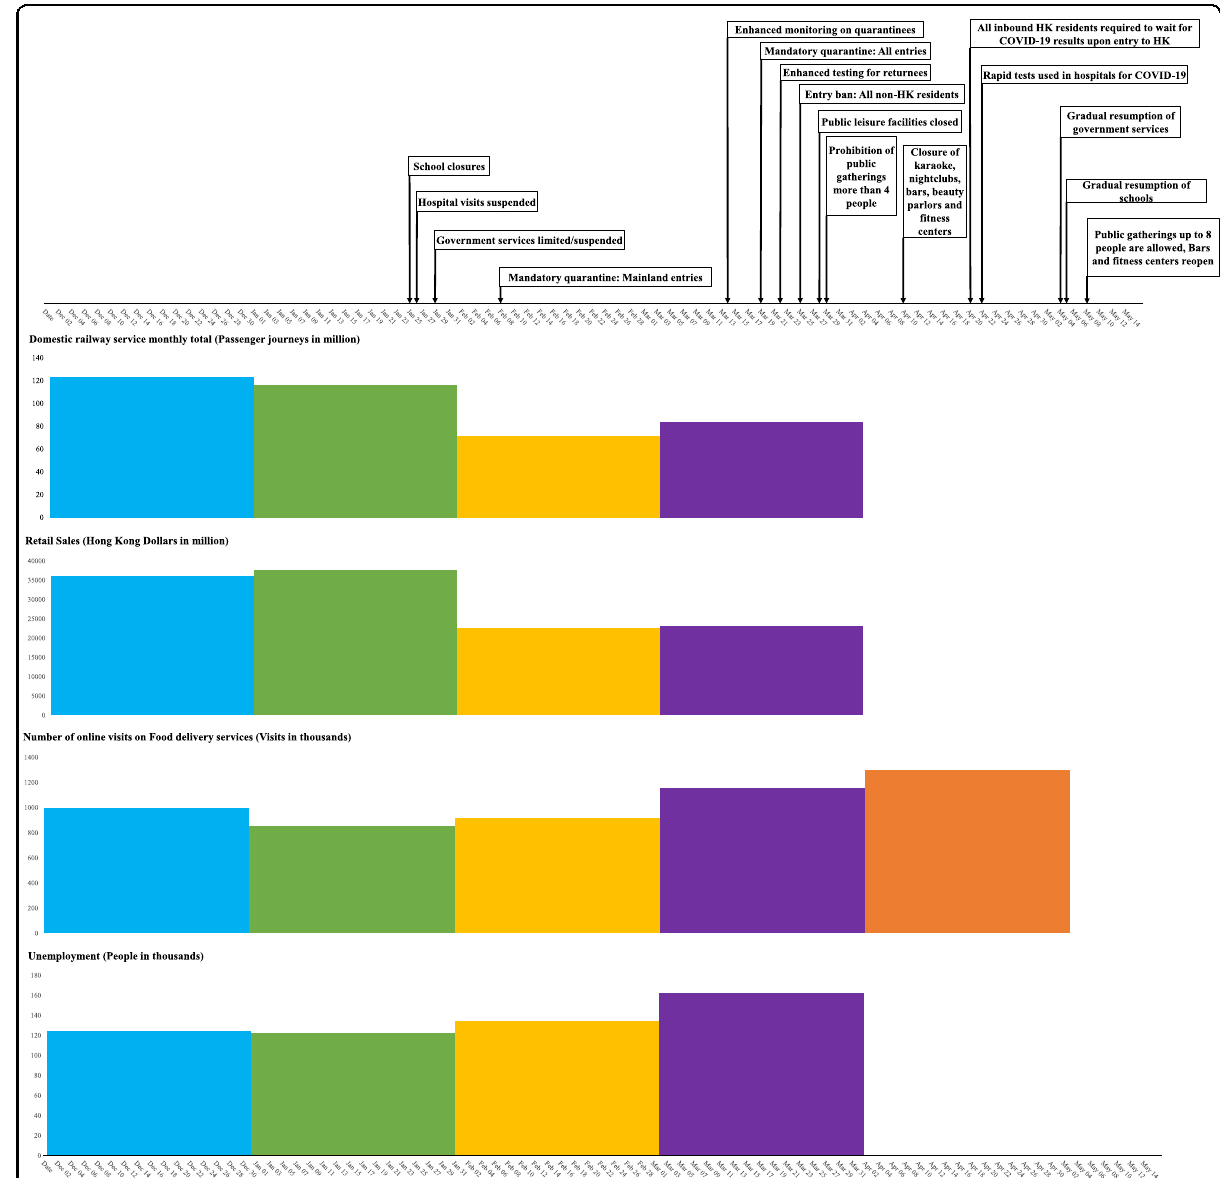
Fig. 1 Changes in population behavior between December 2019 and May 2020. This fi gure illustrates four indicators that re fl ected changes in population behavior during the COVID-19 pandemic in Hong Kong. Monthly total domestic railway service users were reported by the Mass Transit Railway (MTR) Corporation of Hong Kong, the sole railway provider in Hong Kong. The data represents the monthly total number of passengers. Data on retail sales and unemployment were extracted from the Hong Kong Monthly Digest of Statistics provided by the Census and Statistics Department of the Hong Kong SAR government. Retail sales represents the monthly total retail sales in Hong Kong across all retail outlets, and unemployment represents the total number of unemployed residents in Hong Kong across all industries. The number of visits on food delivering services were extracted from SimilarWeb and the data shows the total number of online visits to Food Panda and Deliveroo, the two major food delivering service providers in Hong Kong. All data were taken as on May 18,